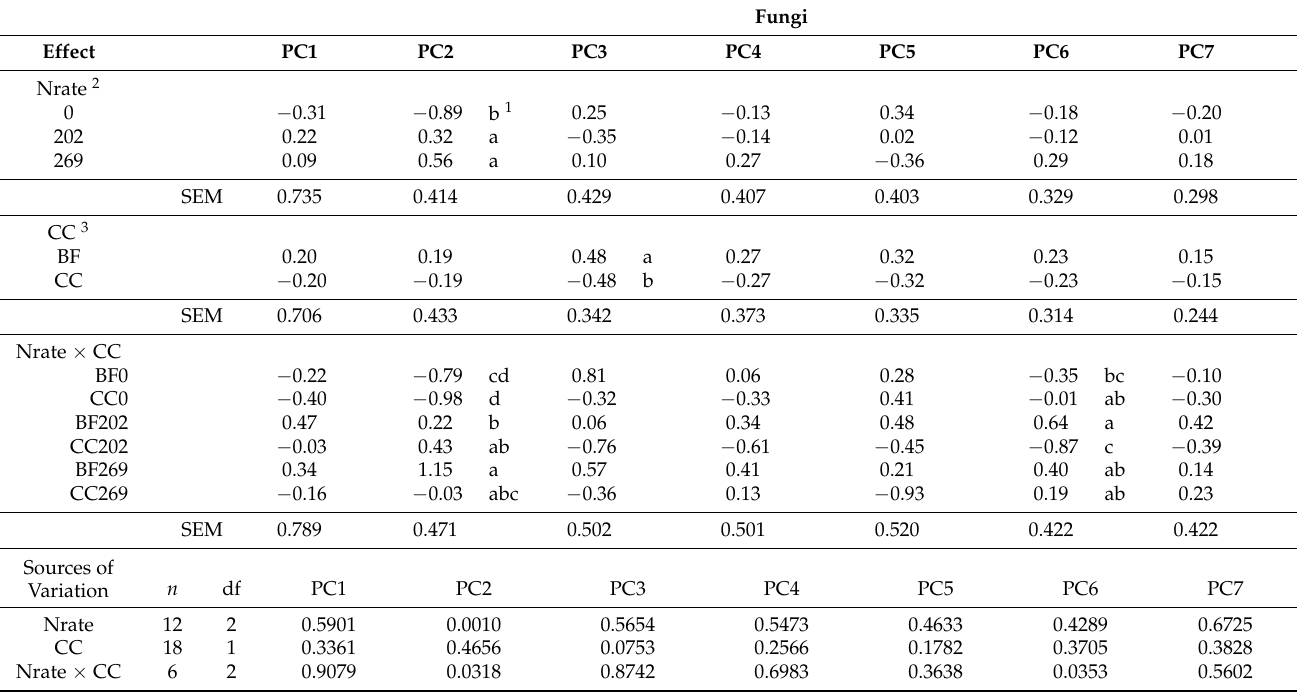
Table 3. The estimated treatment means and standard errors of the mean (SEM) of each group of principal components (PC) calculated for fungal indicators determined by the main effects of N fertilization (Nrate), cover cropping (CC), and their interaction. Probability values ( p -values), sample size ( n ), and degrees of freedom (df) associated with the different sources of variation from Type III Test analysis of variance results are shown